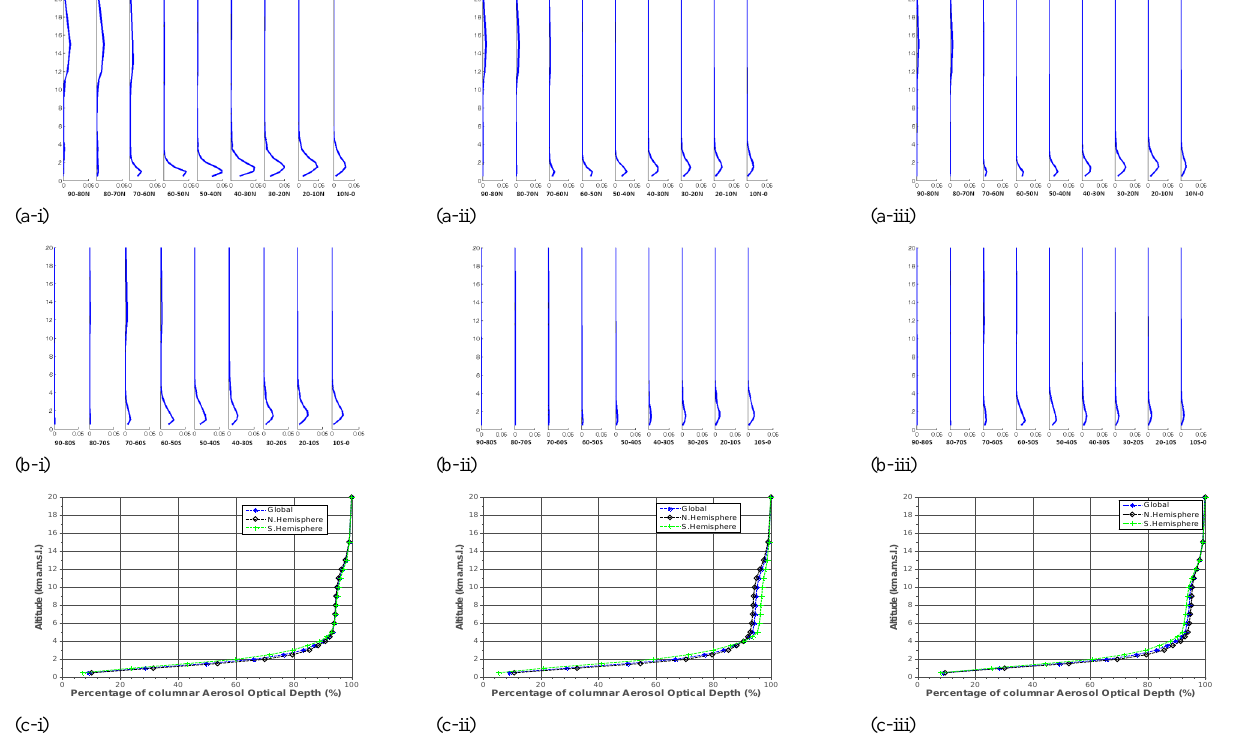
Figure 7. Vertical distribution of HAC AOD for total (left column, i), fine (middle column, ii) and coarse (right column, iii). HAC layer tops are at 0.5, 1.0, 1.5, 2.0, 2.5, 3.0, 3.5, 4.0, 4.5, 5.0, 6.0, 7.0, 8.0, 9.0, 10.0, 11.0, 12.0, 13.0, 15.0, and 20.0km. Results are given in averages over 10-degree latitudinal zones of Northern Hemisphere (first row, a ) and Southern Hemisphere (second row, b ). In the third row (c) , the cumulative fraction of columnar AOD (in %) is given as function of altitude (in km) averaged over the two hemispheres and the